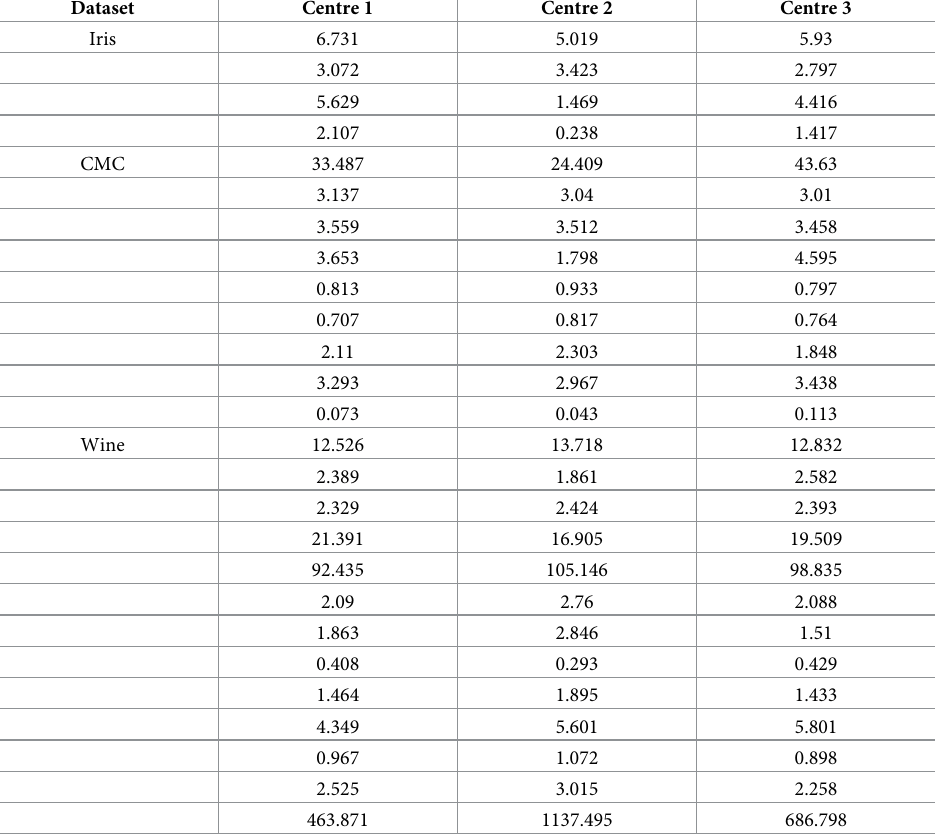
Table 6. The best clusters centres on the datasets Wine, Iris, and CMC obtained by the AMADE algorithm. Dataset